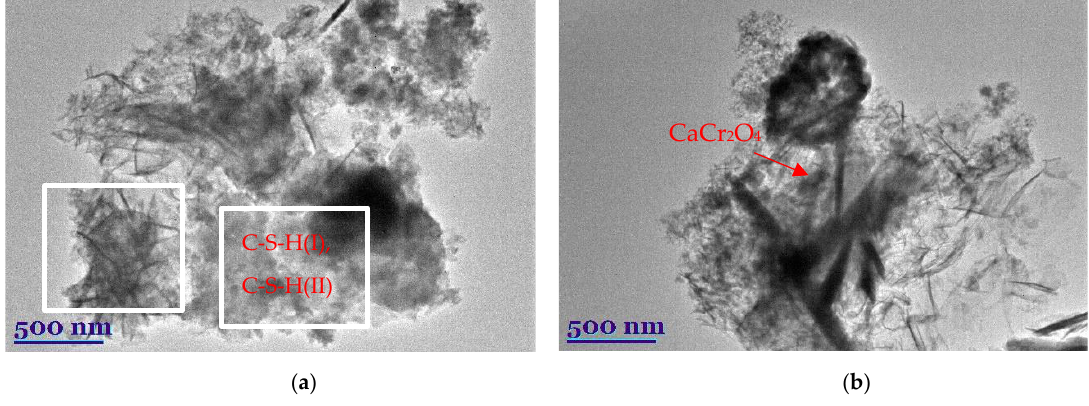
Figure 5. TEM micrographs of synthetic ( a ) and calcined ( b ) samples.